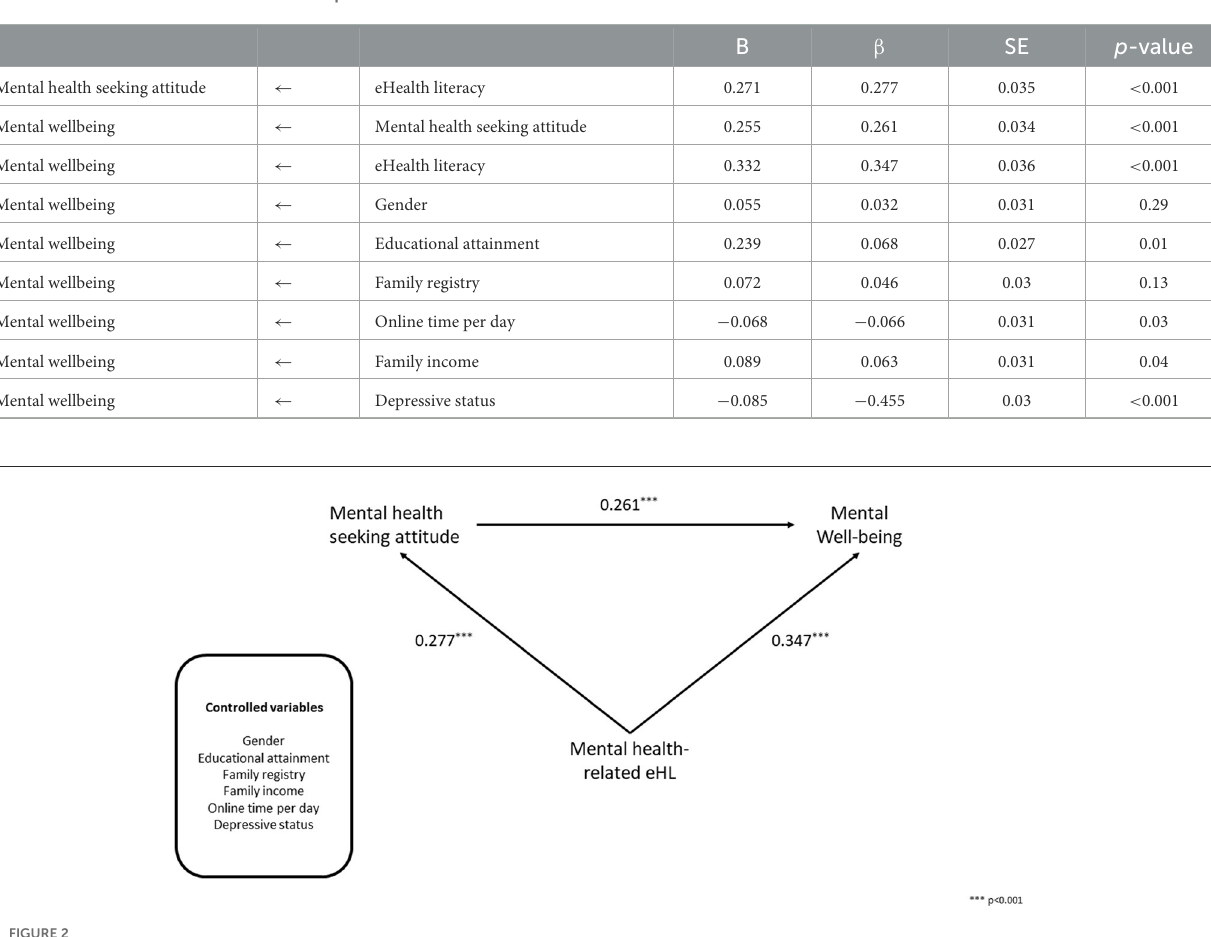
TABLE 4 Unstandardized and standardized path coefficients for SEM.